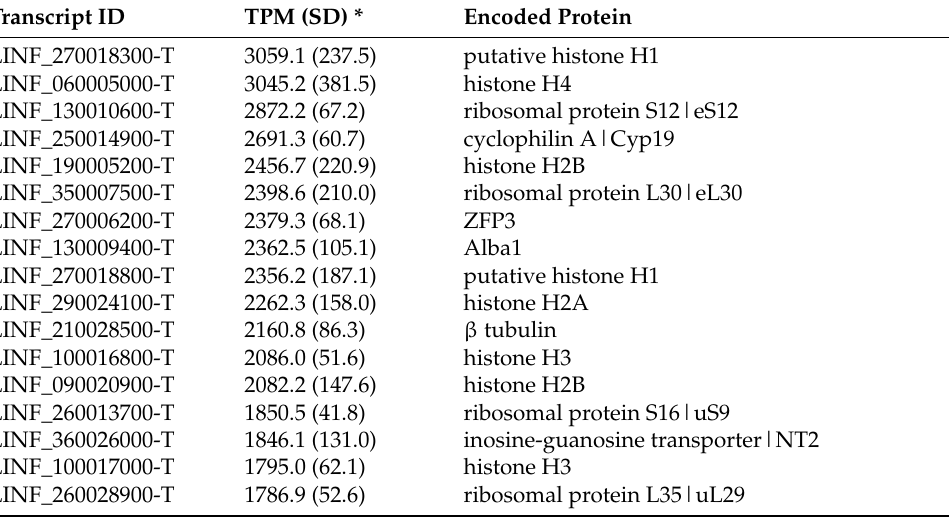
Figure 3. Steps for creating gene models. ( A ) Transcripts are assembled from Illumina RNA-seq reads. ( B ) SL-containing RNA-seq reads are used to map the SL-addition sites (SASs); the main SAS (vertical arrow) is assigned to that supported by the largest number of SL-containing RNA-seq reads, and the rest as categorized as alternatives (see Supplementary File S1 for complete lists of main and alternative SASs). ( C ) Transcript is trimmed according to the position of the main SAS. ( D ) Coding sequences (CDS) are automatically annotated by the Companion tool. ( E ) If CDS surpasses transcript 5 (cid:48) -end, the CDS is manually shortened at the 5 (cid:48) -end. ( F ) After embedding the CDS into the transcript sequence, the gene model emerges with their 5 (cid:48) and 3 (cid:48) untranslated regions (UTRs). Table 1. The 40 most abundant transcripts in L. infantum (JPCM5 strain)